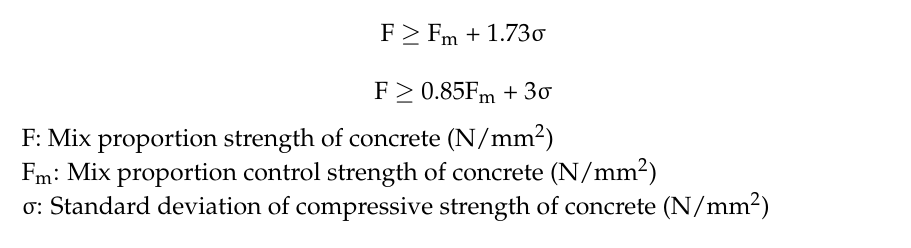
Table 10. Outline of the applied structure.